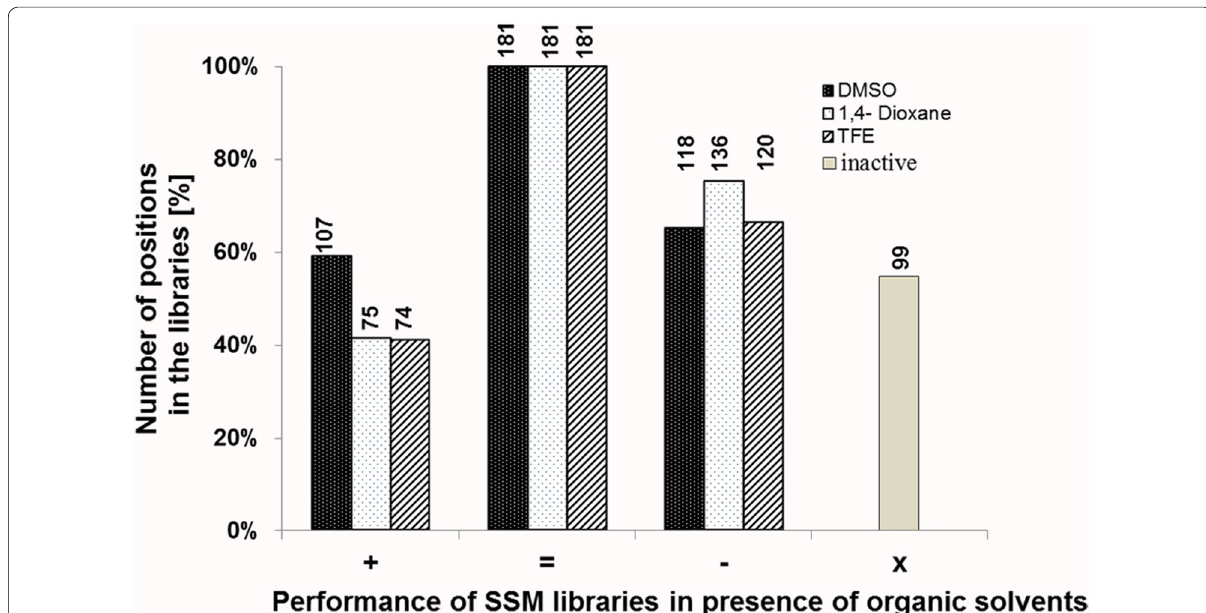
Fig. 1 Number of amino acid positions which lead to improved/unchanged/decreased organic solvent resistance and inactivation of BSLA in buffer. : variants with improved resistance; +